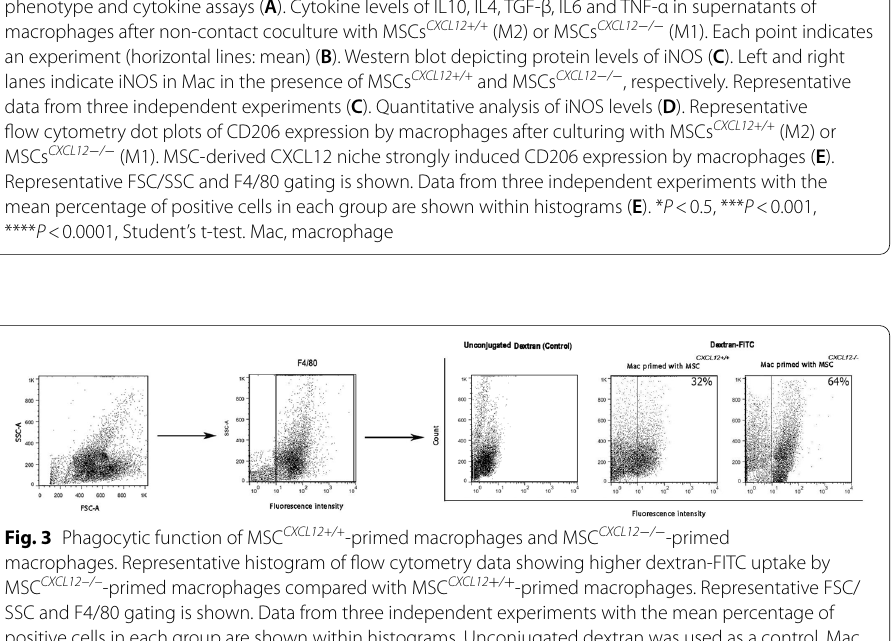
phagocytic potency compared with MSC CXCL12 + / + -primed macrophages. Our results showed that CXCL12 is a significant inhibitor of macrophage phagocytic activity.